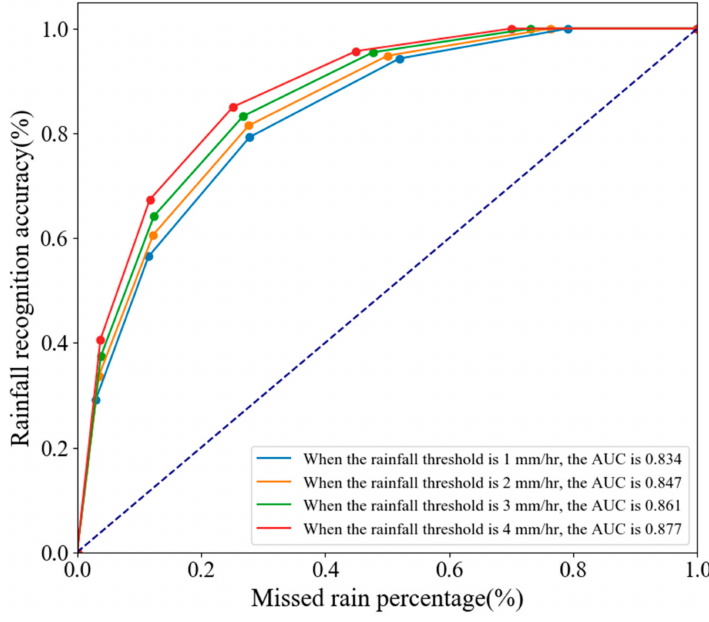
Figure 6. ROC curve under different rain thresholds. Table 2. Improvement of wind field quality from HY2RRM 0.5 and HY2RRM 0.6 under different rain